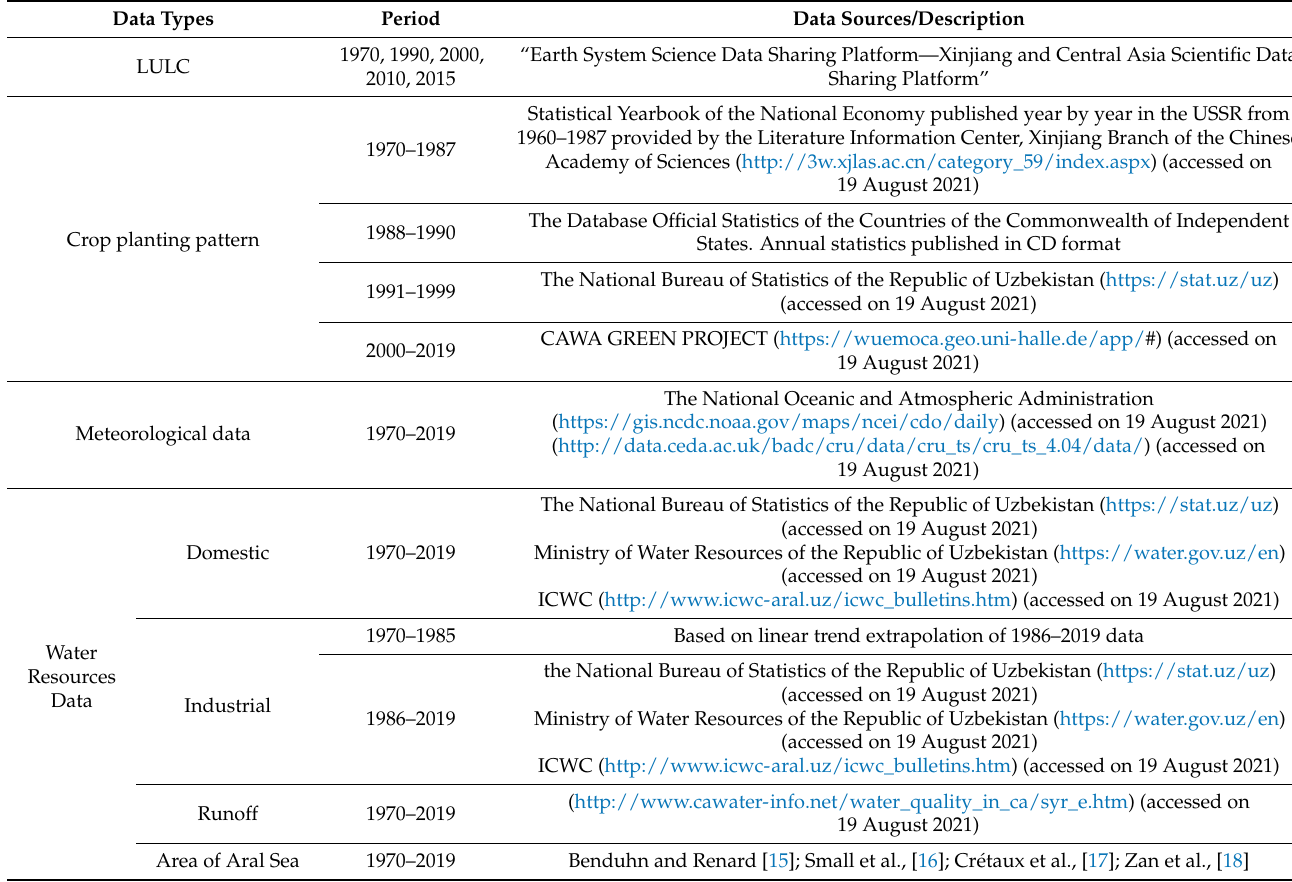
Table 1. The detailed description of the